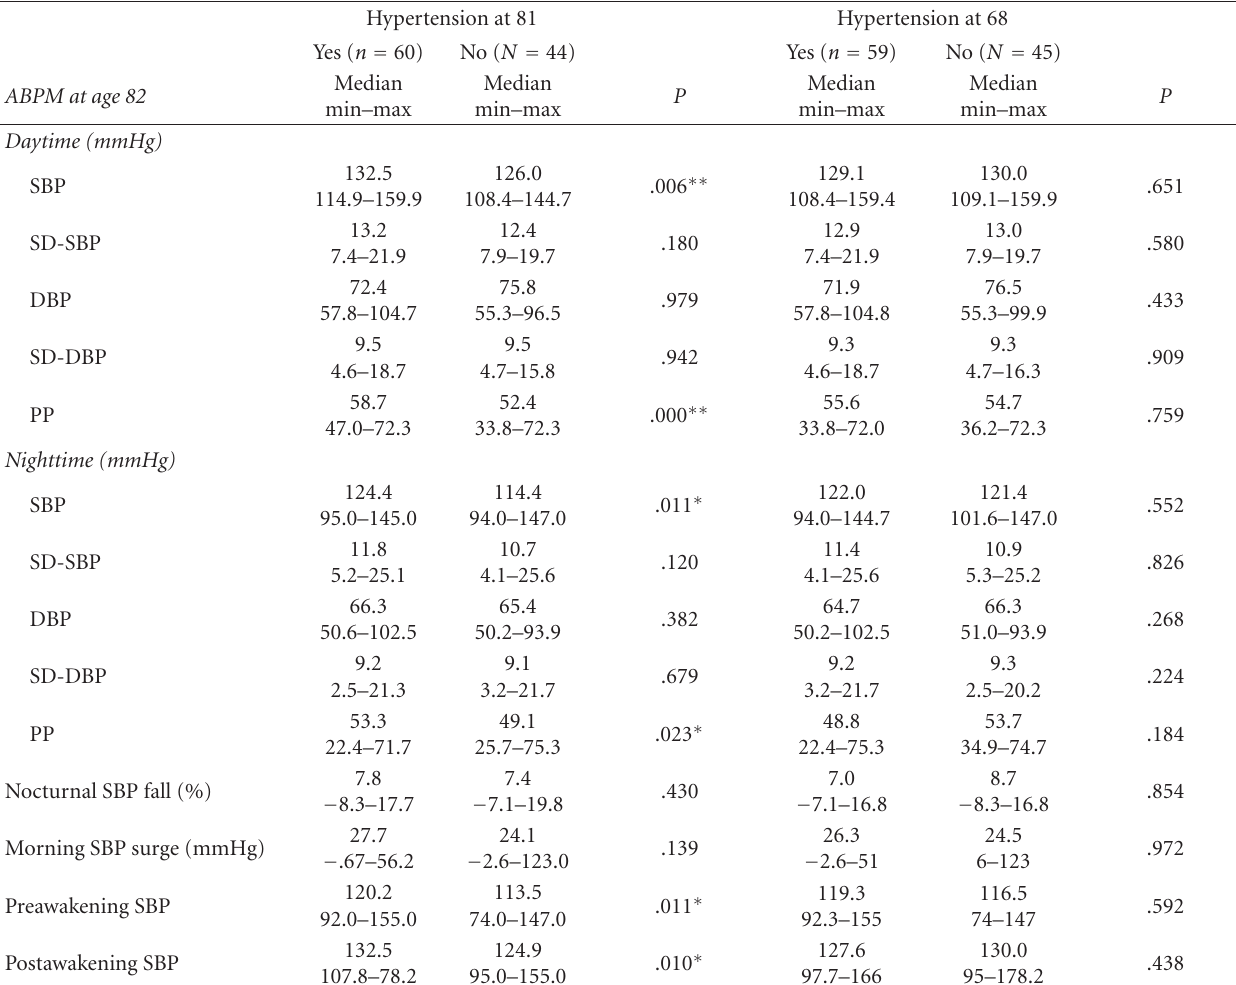
Table 2: Ambulatory blood pressure values measured in elderly men at age 82, who were diagnosed hypertensive versus normotensive during examinations at age 81 and 68